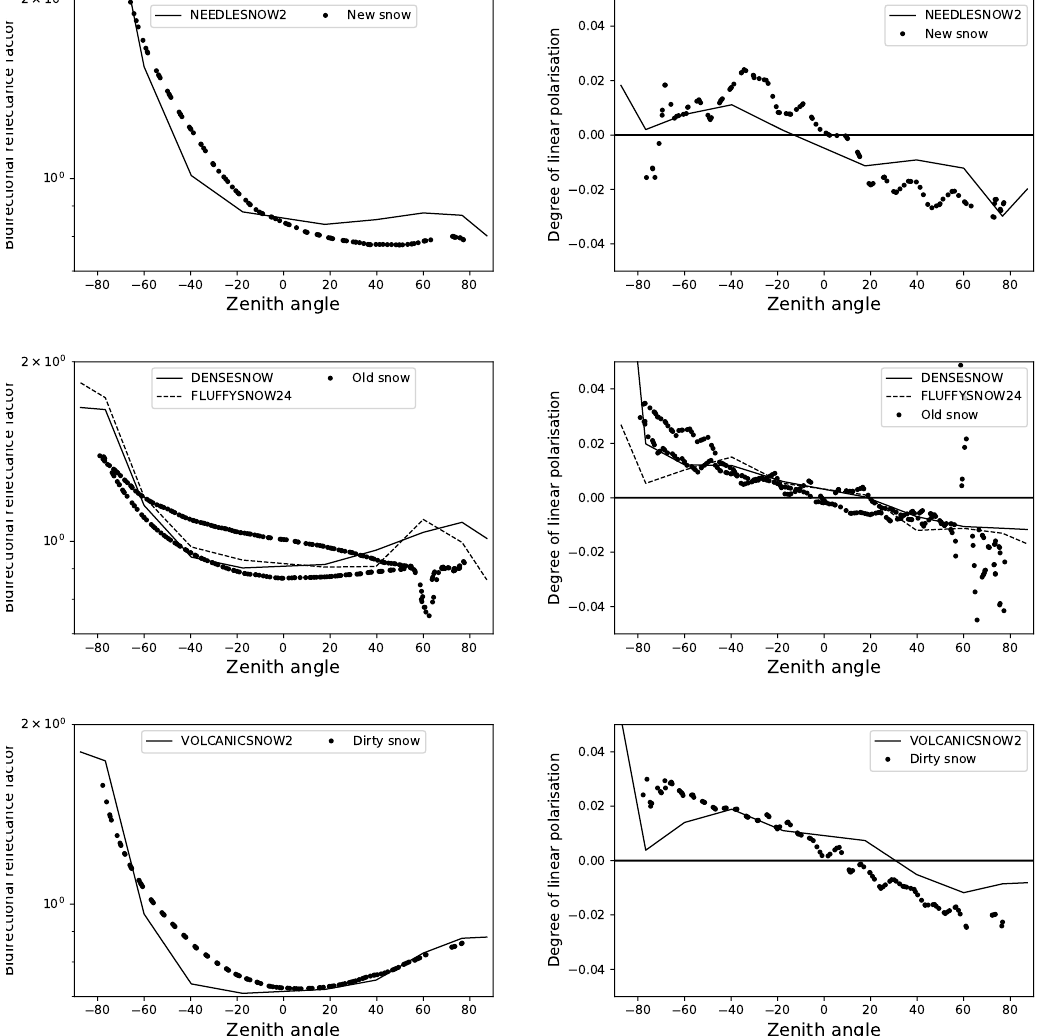
Figure 3. Modelled BRF (left) and DQP (right) of several snow types compared with experimental data (dots). From top: new snow measured on a lake at Sodankyl¨a 2010-03-16, old snow measured at Sodankyl¨a airport 2013-04-04 (two dot lines taken 30 minutes and 20 cm apart), snow doped with dark volcanic sand